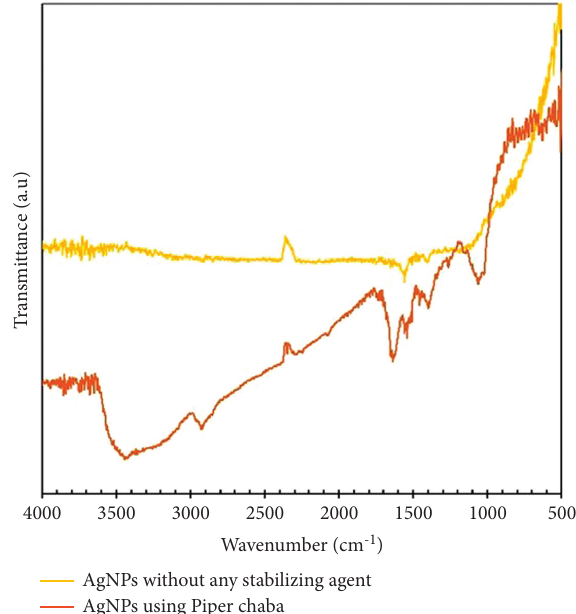
Figure 1: Fourier transform infrared (FTIR) spectra of Ag NPs synthesized using AgNO 3 (1mM, 40mL) and Piper chaba extract (100g/L, 2mL) after the reaction for 1h at 60 ° C and pH � 7, and Ag NPs synthesized without capping agent reduced by NaBH 4 [59] (open access and reprinted under CC BY